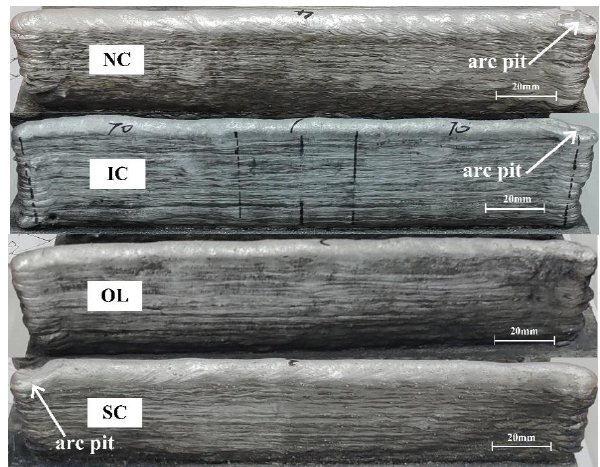
Figure 5. Temperature of each layer deposited by different cooling processes.